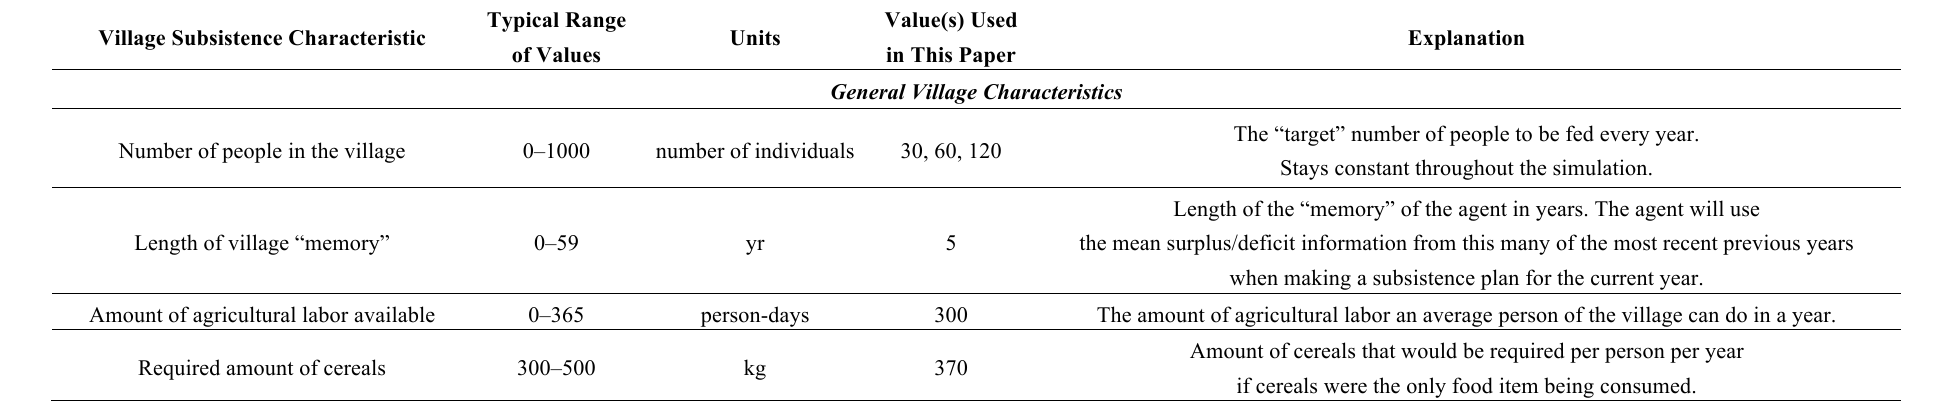
Table A2. Table of agropastoral parameters used in the stochastic agropastoral simulation component of the